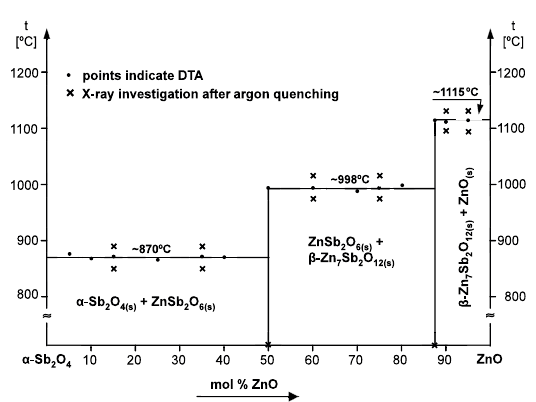
Figure 2. The ranges of phase coexistence: α -Sb